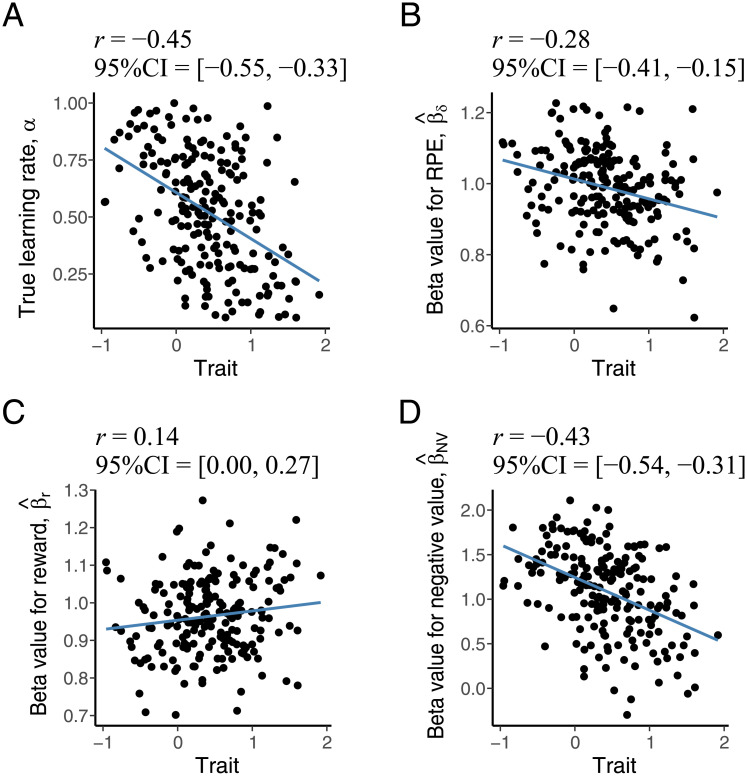
Spurious individual difference on model-based fMRI can occur in dimensional approaches (focusing on continuous trait, rather than group difference).(A) Simulated data showing correlation between trait (e.g., symptom score) and ground truth learning rate. (B) Correlation between trait and beta values for RPE in GLM1. (C, D) Correlation between trait and beta values for reward (C) and negative value (D) in GLM2. Above each panel, r indicates the correlation coefficient and ‘’95% CI” indicates the 95% confidence interval of the correlation coefficient.